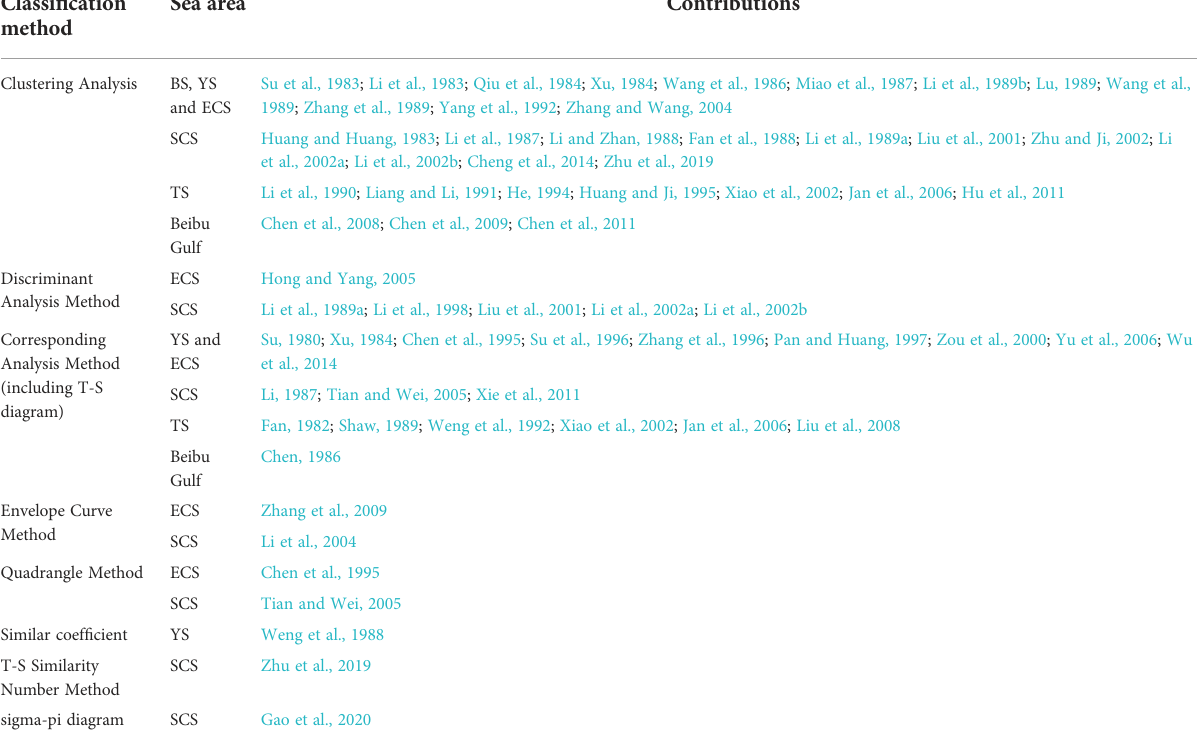
TABLE 1 A collection of papers on water mass analysis by classi fi cation method and sea areas in the China seas from 1980 to